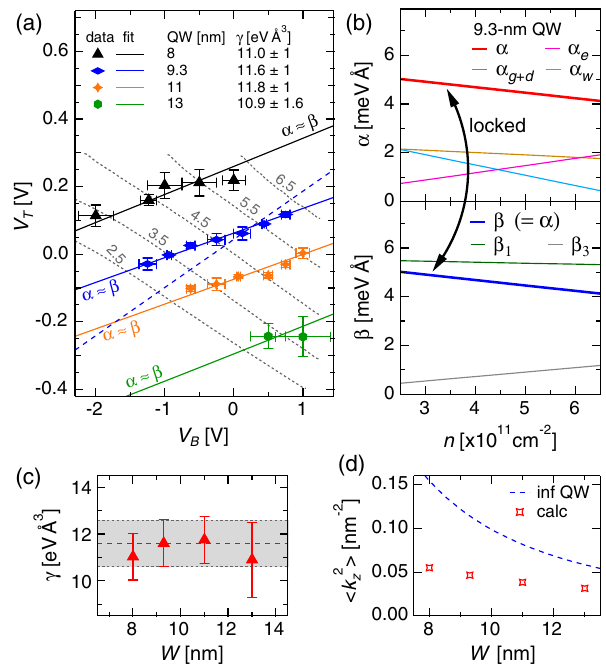
FIG. 3. Tuning and continuously locking α ¼ β . (a) The markers indicate α ≈ β for four different well widths (asymmetric doping) and various densities (gray contours of constant n , labeled in units of 10 11 cm − 2 ) in the V and V plane. Error T B bars result from the finite number of conductance traces in the ð V Þ space. Theory fits (solid lines) are shown for each well, ; V B T with γ as the only fit parameter (inset table, error bars dominated by systematic error; see below). The dashed blue line indicates the slope of constant α ¼ β 1 , neglecting β 3 , which is inconsistent with the data. (b) Simulation of locked α ¼ β versus density n along solid blue line from (a), showing the various SO contri- butions (see text). (c) Values of γ from fits for each well width W . Red dashed line is the average γ ¼ 11 . 6 (cid:3) 1 eV Å 3 (excluding W ¼ 13 nm due to its larger error), gray area is the ∼ 9% error, stemming mostly from the systematic uncertainty in the input i as a parameters of the simulations (see Appendix). (d) h k 2 z function of well width W for realistic (markers) and infinite (blue) matched regime, the SO field is not uniaxial, spin rotations do not commute, and trajectories in time-reversal loops interfere destructively upon averaging [26] due to the SO phases picked up along the loops, thus leading to WAL.